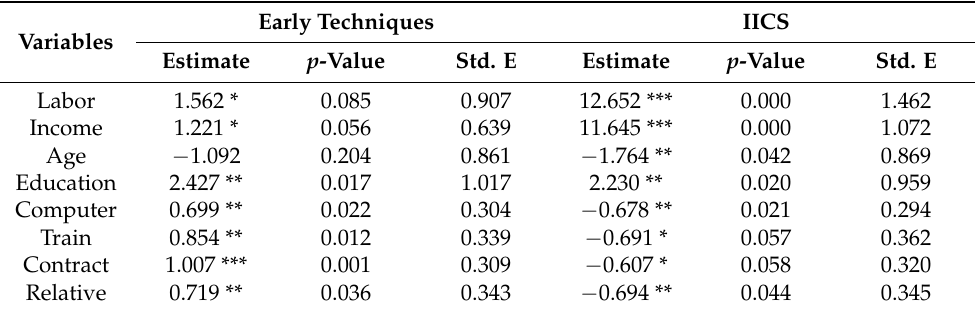
Table 10. Estimation results after excluding